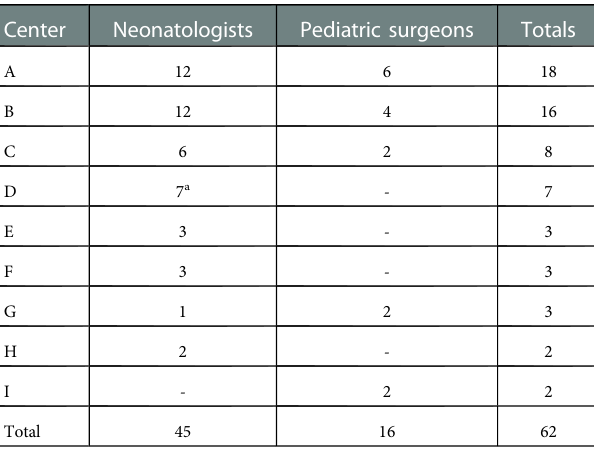
TABLE 2 Participants per